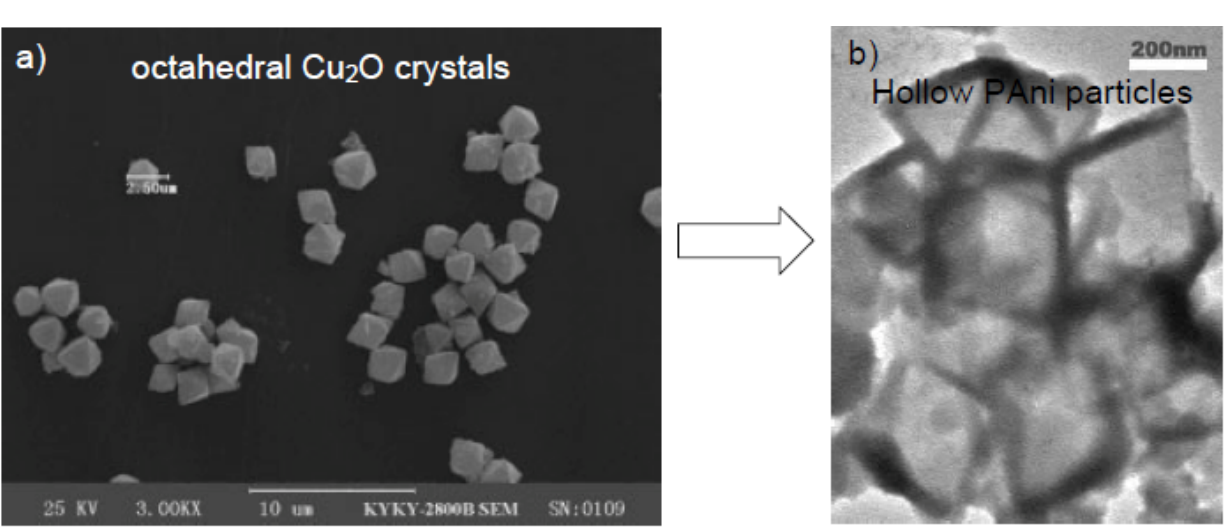
O crystal template; b ) Polyaniline 2